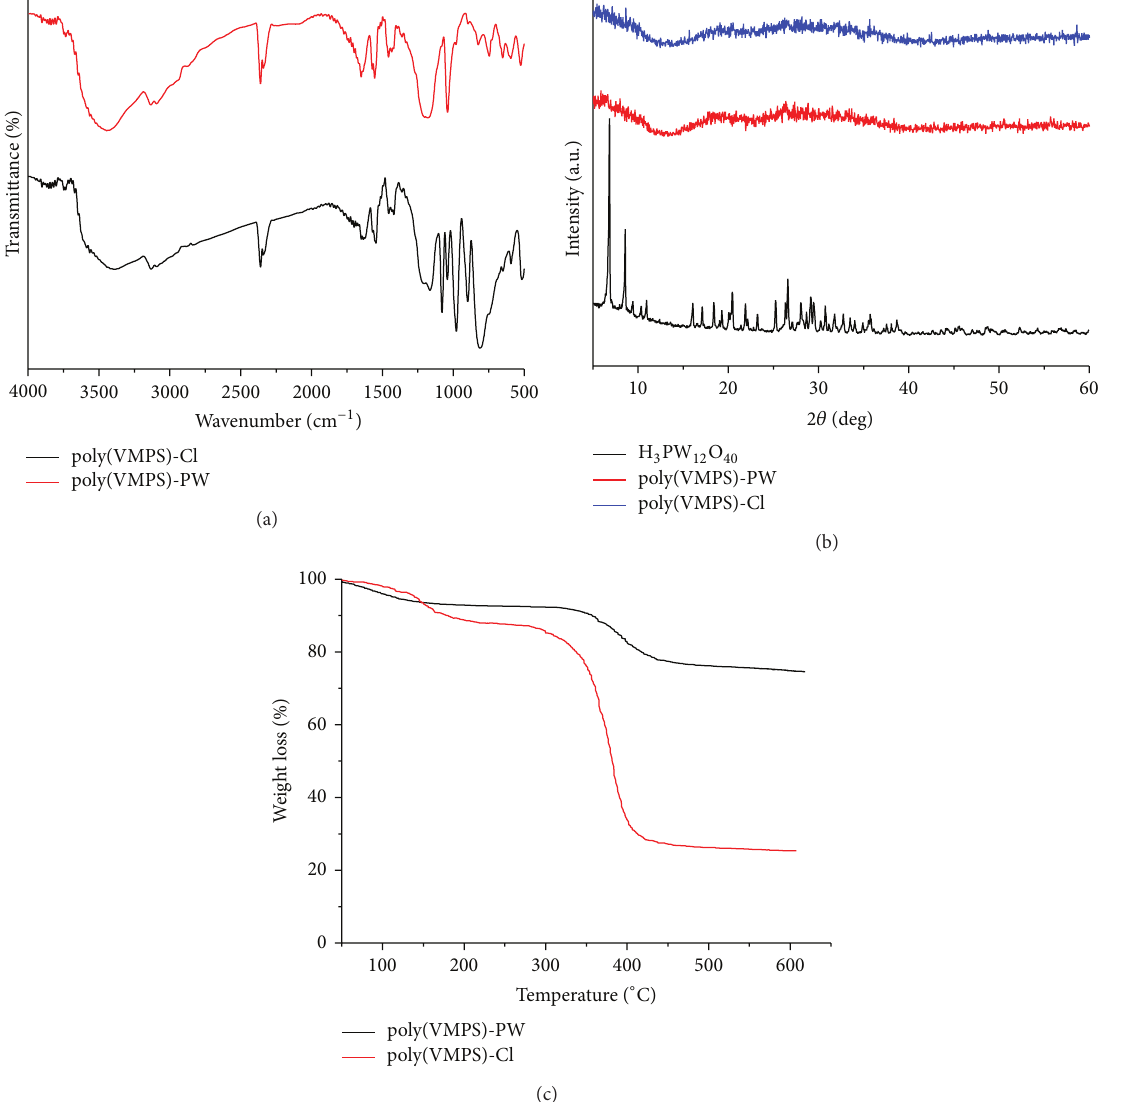
Figure 2: FTIR spectra (a), XRD patterns (b), and TG analysis (c) of powder